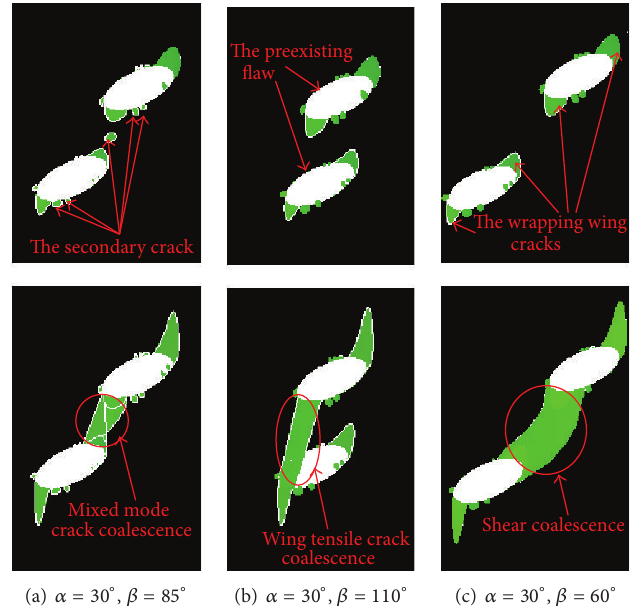
Figure 6: Three different patterns of 3D crack coalescence are observed in the